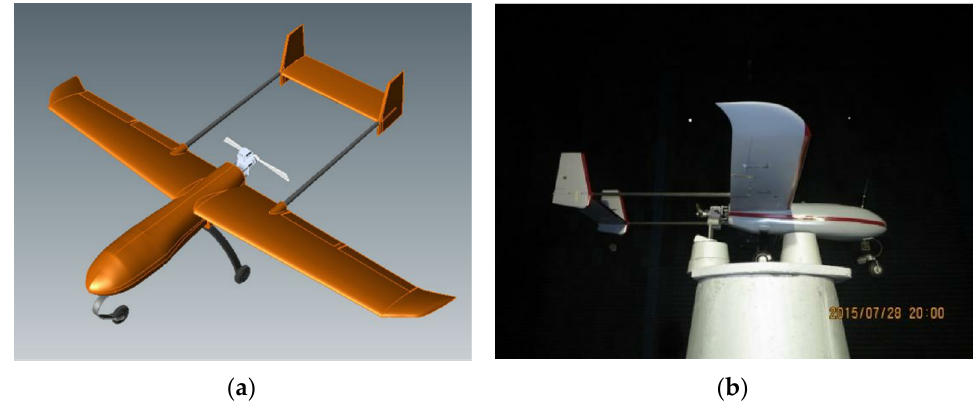
Figure 10. ( a ) ‘Pioneer’ UAV model; ( b ) Measurement scene in the microwave anechoic chamber. The full-polarization data of the UAV was obtained by static measurement of complete sweep signal. The parameters of sweep signal are shown in the table below. As shown in Table 4, the complete sweep signal consists of 200 sub pulses with a frequency range from 8GHz to 12GHz and bandwidth of 4GHz. Table 4. Parameters of sweep signal.